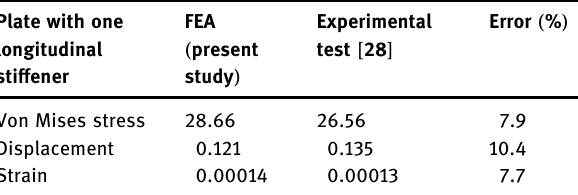
Table 2: Validation test carried out for an FEA and experimental test Plate with one longitudinal